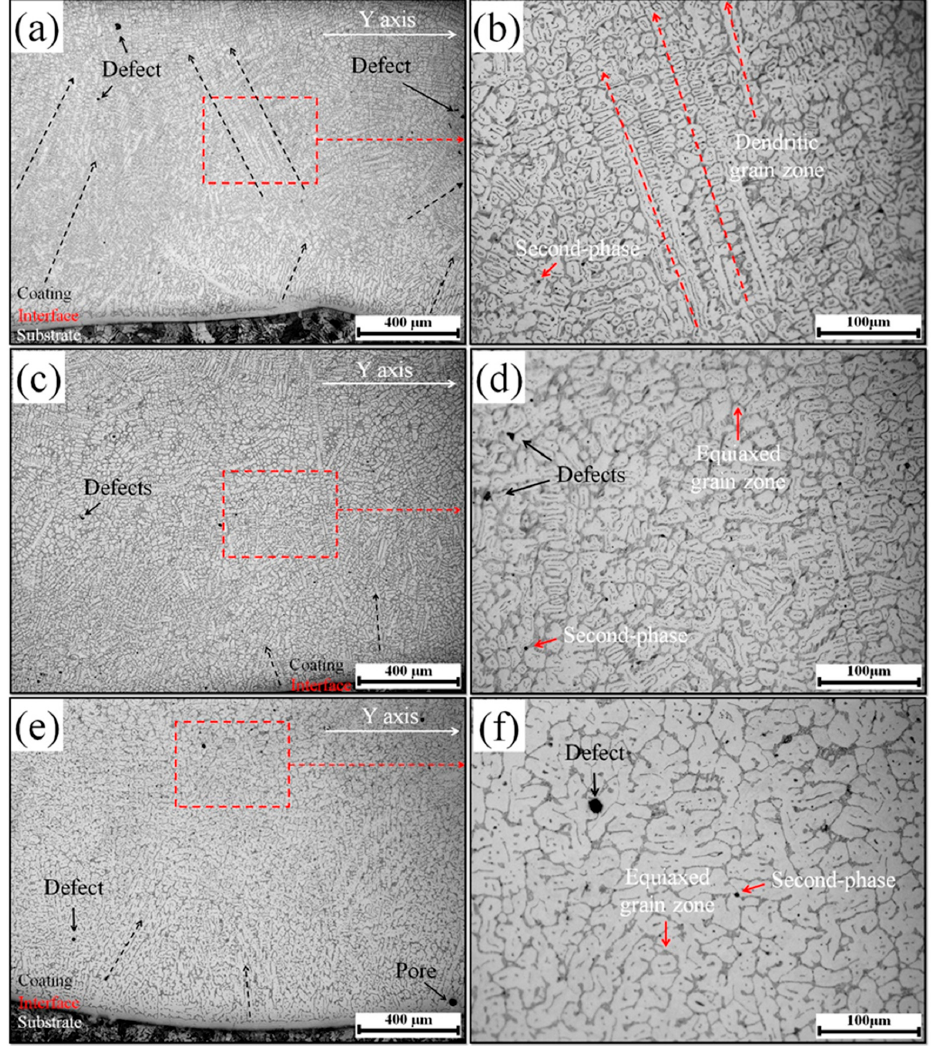
Figure 3. The cross-sectional morphologies of the coating samples: ( a ) HSC0, ( b ) Enlarged image of ( a ), ( c ) HSC04, ( d ) Enlarged image of ( c ), ( e ) HSC08, ( f ) Enlarged image of ( e ).